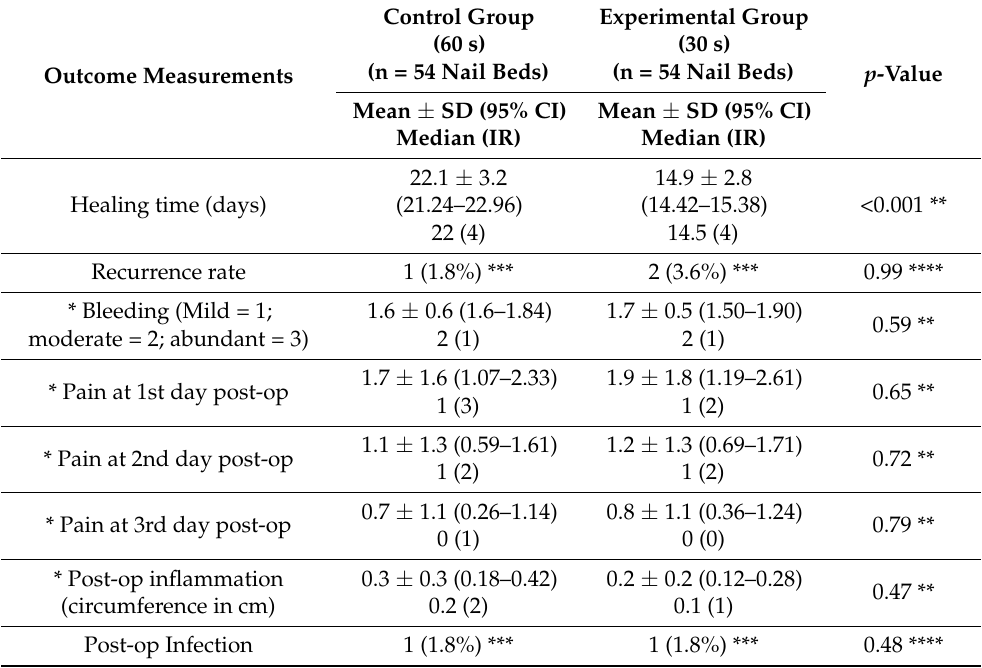
Table 1. Clinical variables studied at control and experimental